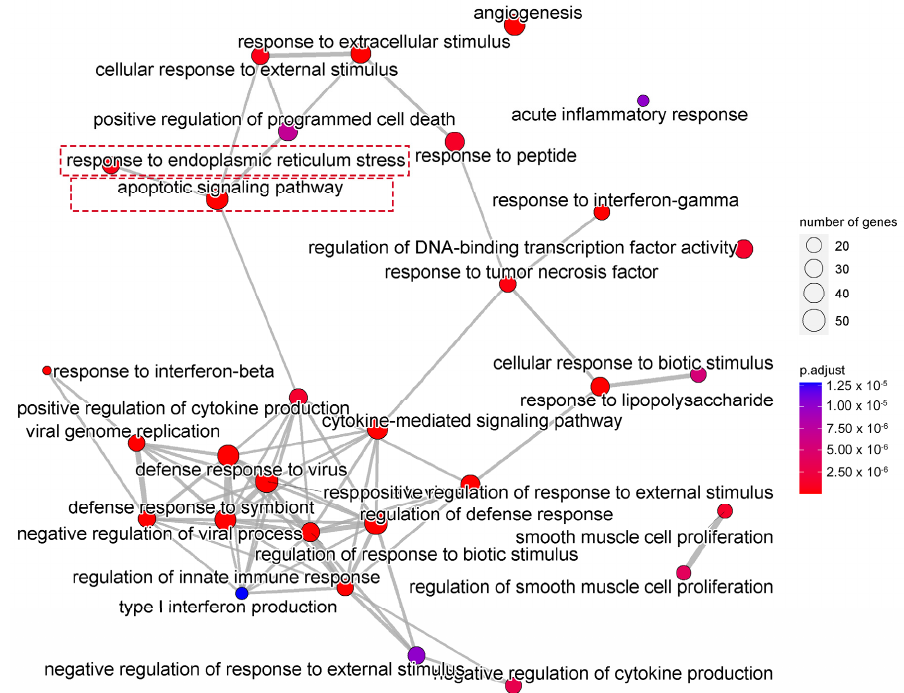
Figure 4. Network showing the overlapping gene sets among the GO-BP terms after removing redundant genes. GO, gene ontology; BP, biological processes.